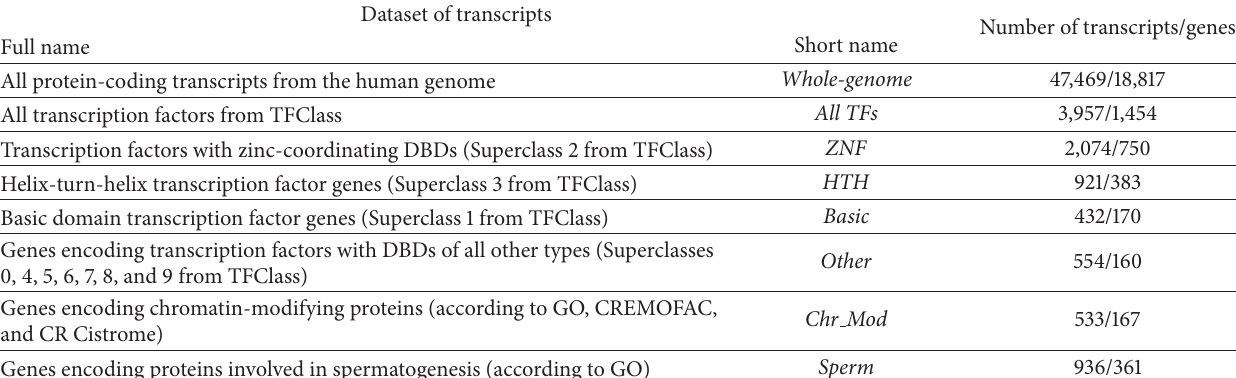
Table 1: Sequence sets used in analysis. The column “number of transcripts/genes” presents the count of transcripts that were computed after intersection of the respective subset with the whole-genome dataset of 47,469/18,817 transcripts/genes.